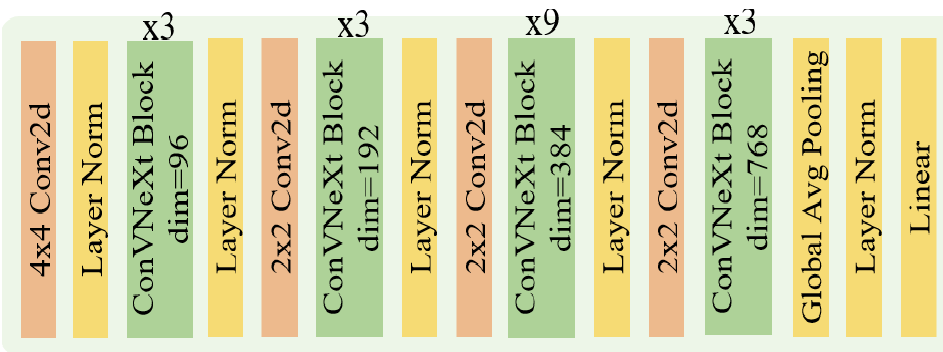
Figure 9. Query set feature extraction backbone.